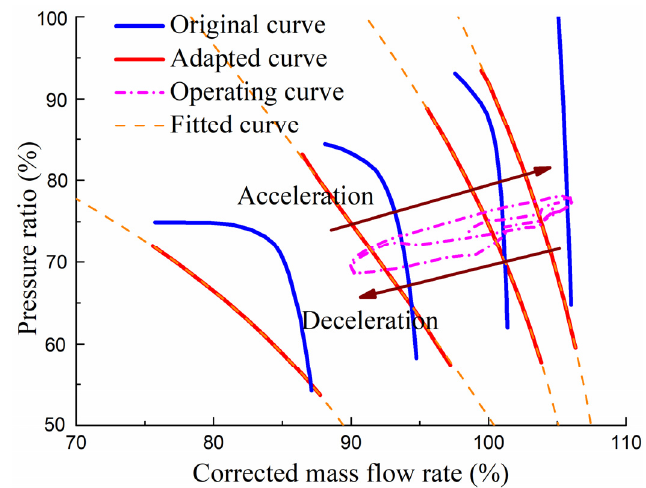
Figure 20. Transient trajectories on the map.